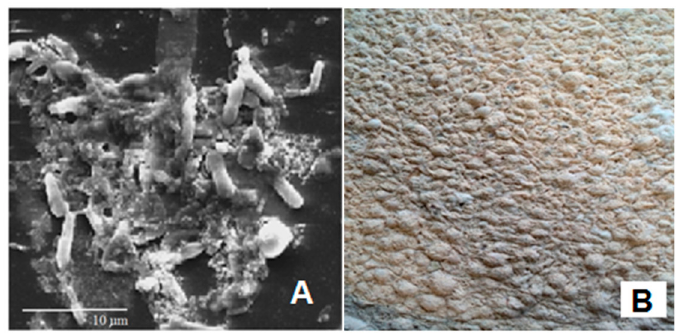
Figure 2. SEM observation of a representative microbial film (A) from brine sampled in the headspace of a barrel contaminated by yeast film (B).